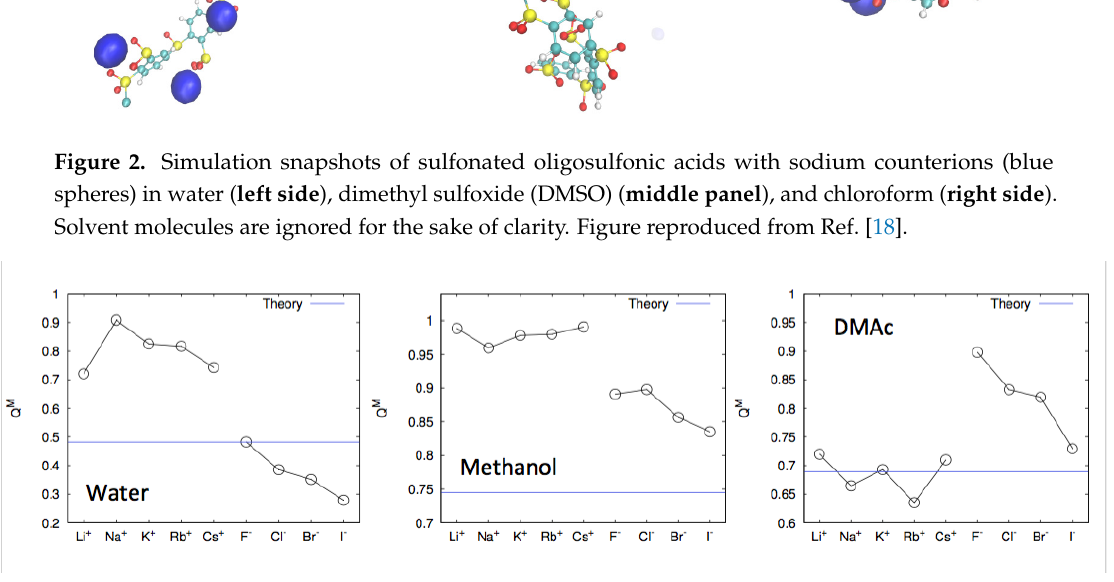
Figure 3. Fraction of condensed counterions around cylindric model polyelectrolytes with identical charge density in water ( left side ), methanol ( middle ) and dimethylacetamide (DMAc, right side ). The straight blue lines correspond to the predicted fraction of counterions from counterion condensation theory. Figure reproduced from Ref.